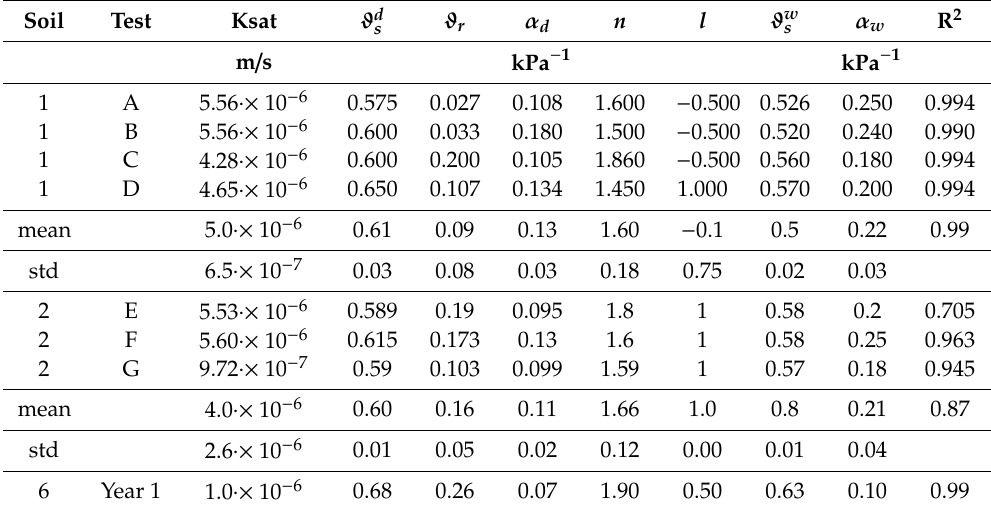
Table 3. Values of Mualem–van Genuchten model parameters of the main drying and main wetting curves derived via inverse analysis of all soils